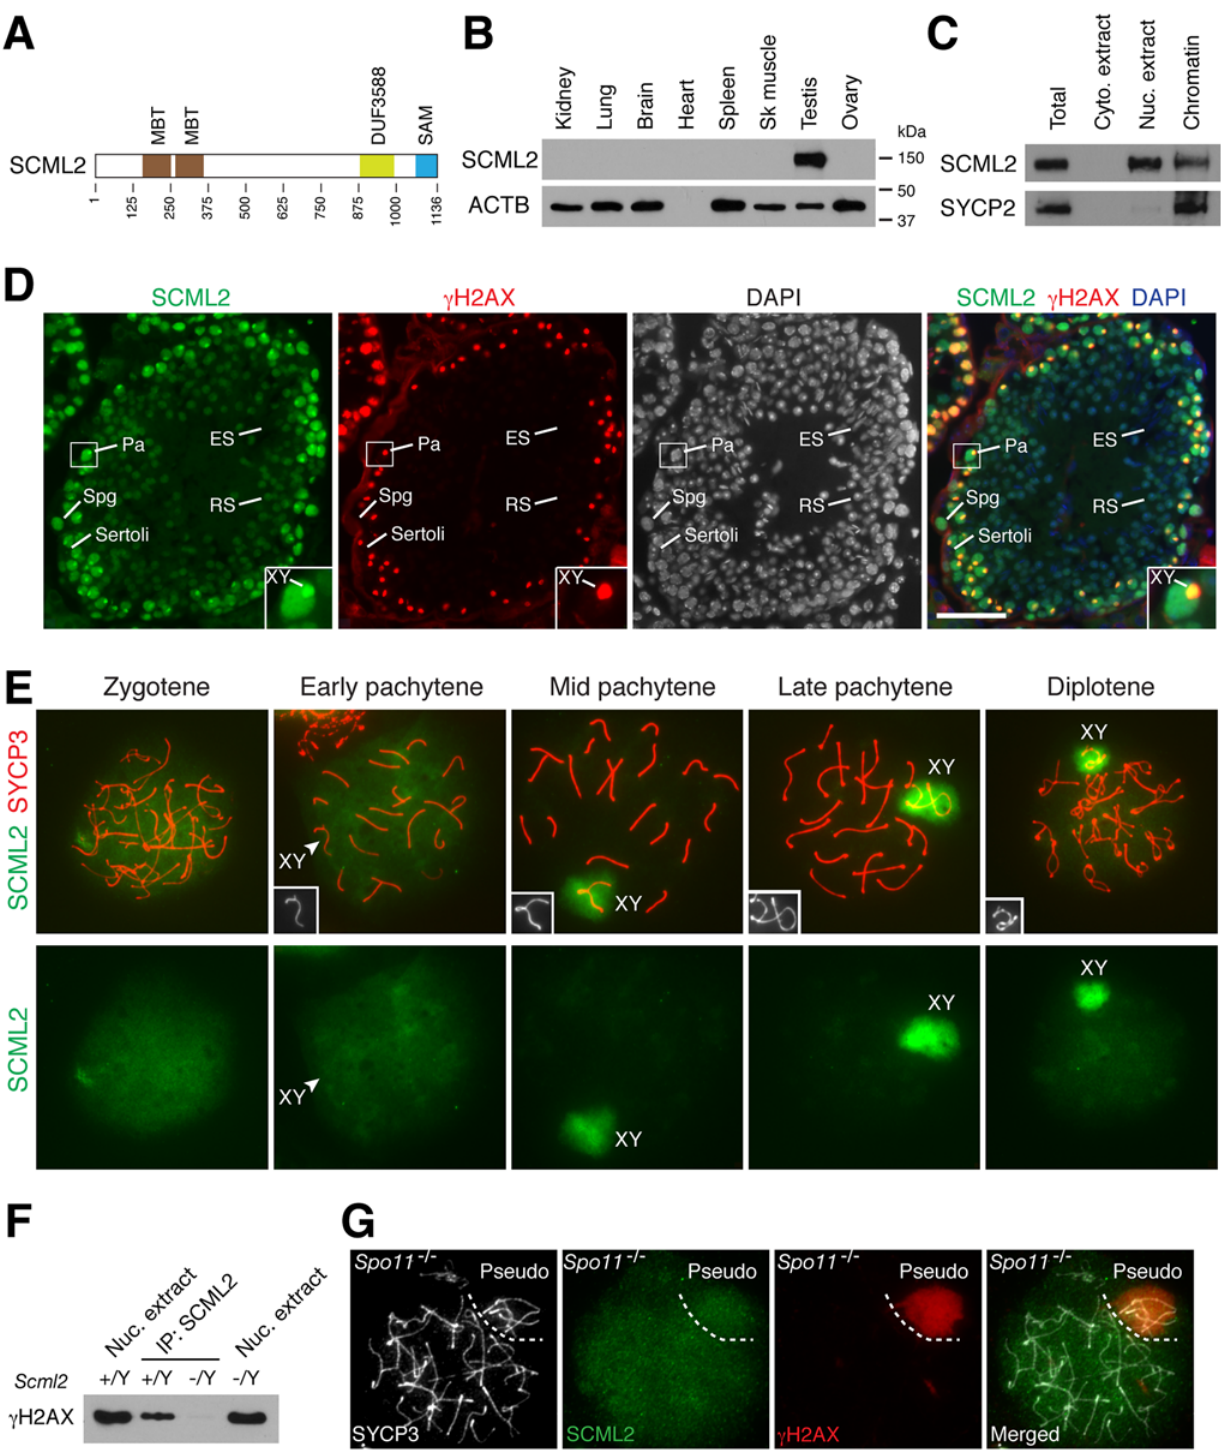
Figure 1. Expression and localization of SCML2 during mouse spermatogenesis. (A) Domain structure of mouse SCML2 protein (XP_006528733.1). MBT, malignant brain tumor repeat; DUF3588, also called Scm-like embedded domain (SLED) [11]; SAM, sterile alpha motif. (B) Western blot analysis of SCML2 in adult mouse tissues. ACTB serves as a control. (C) Western blot analysis of SCML2 on cytoplasmic extract, nuclear extract, and chromatin from postnatal day 20 testis. SYCP2, a synaptonemal complex protein, serves as a control [44]. (D) Expression and localization of SCML2 in male germ cells. Testis sections from 2-month-old mice were immunostained with SCML2 and γ H2AX antibodies. Nuclei were stained with DAPI. The inset is an